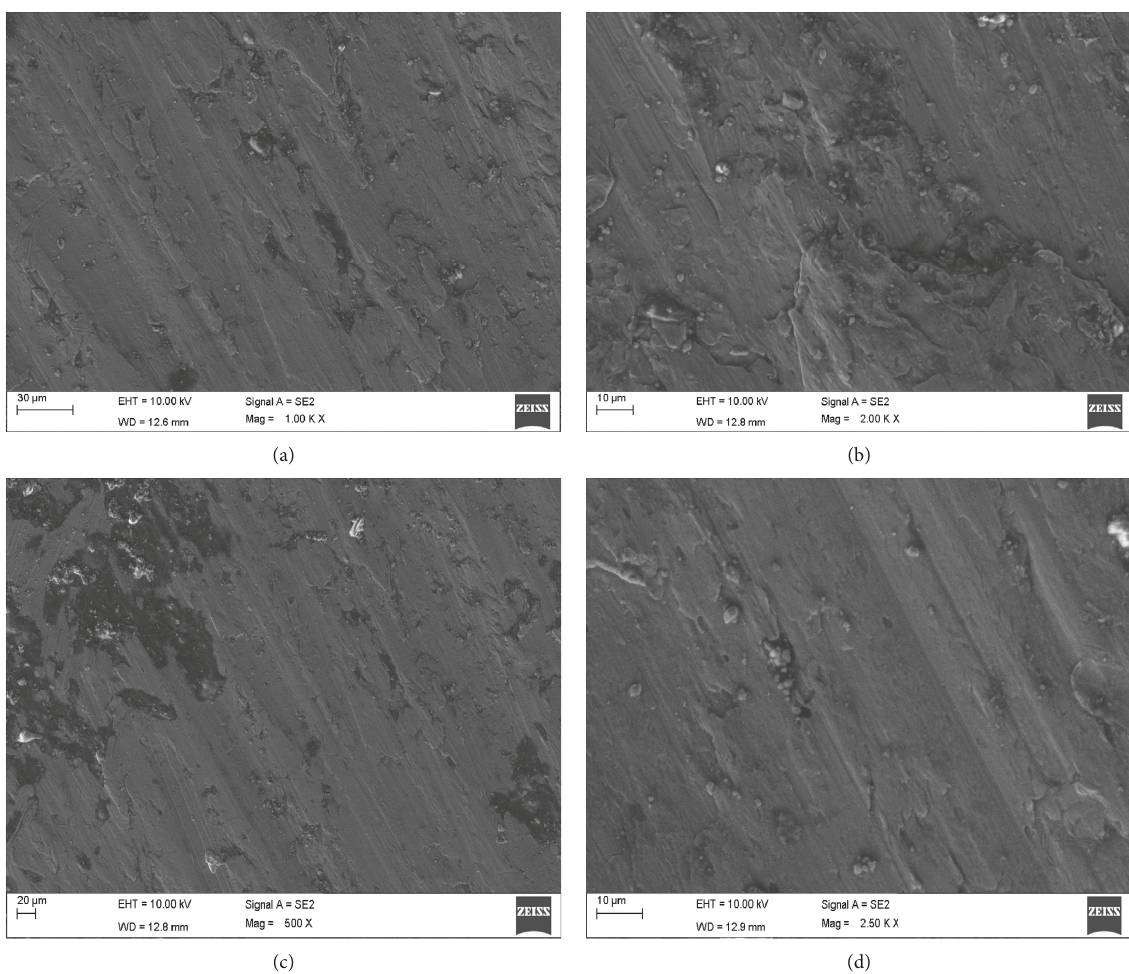
Figure 11: SEM analysis for 4% of reinforcement Al composite with glass